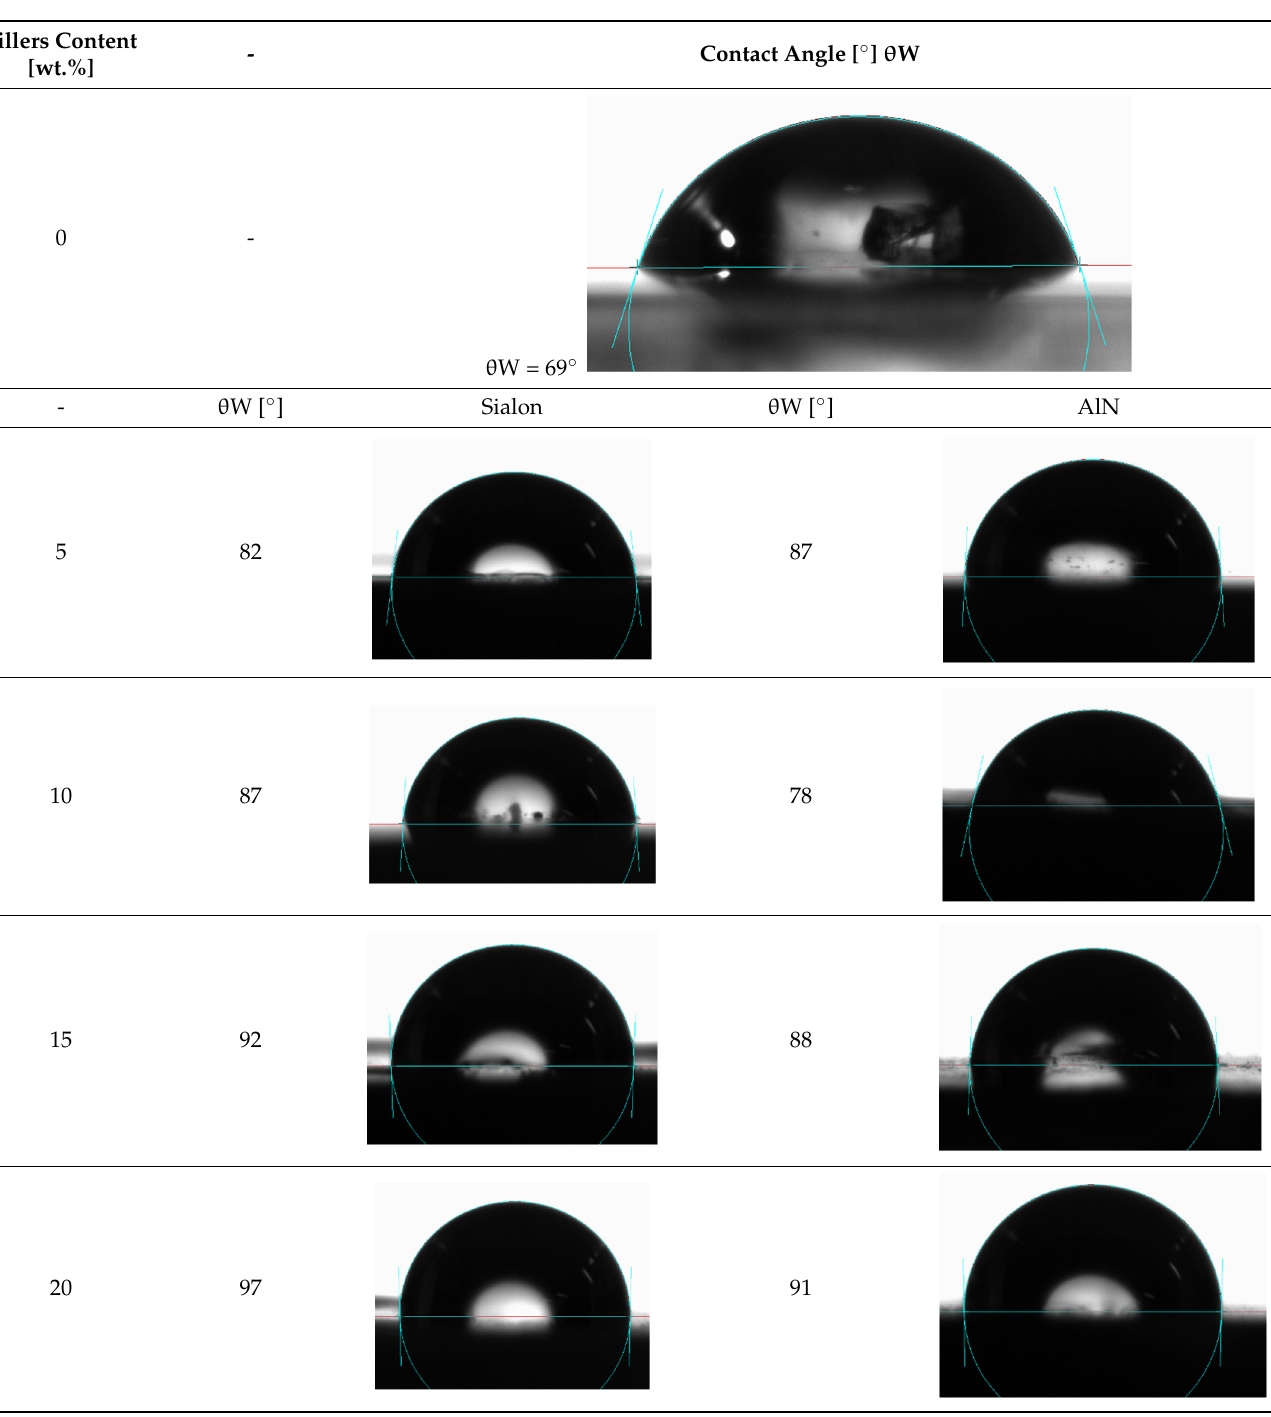
Table 2. The image of contact angle θ W.